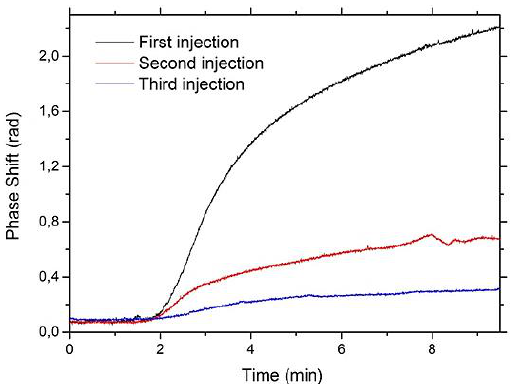
Figure 5. Sensorgram recorded on one single aMZI sensor by flowing a 100 nM AFM1 solution in the microfluidic chamber. The first curve is the response of the fresh sensor, ( black line ), the second one after one glycine –methanol injection ( red line ) and the third one after two injections ( blue line ).